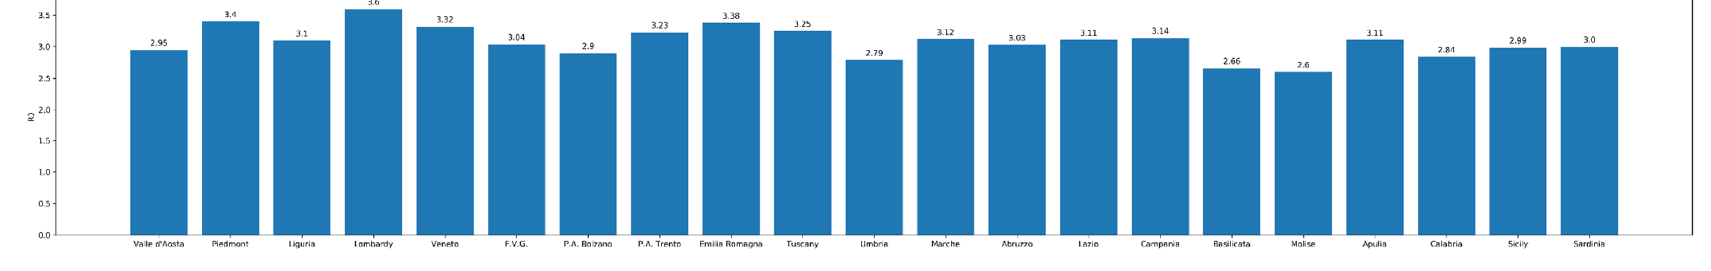
Figure 2. Basic reproductive index computed with the exponential fitting method along the entire time series (1-month period).